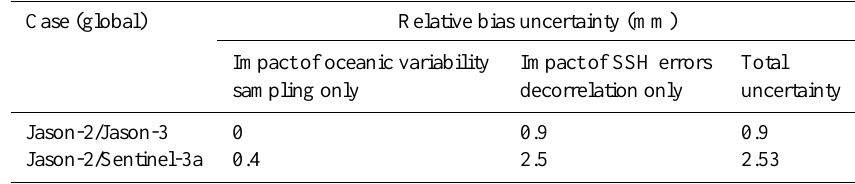
Table 2. Jason-2/Jason-3 and Jason-2/Sentinel-3a relative bias uncertainties on the global mean sea level.